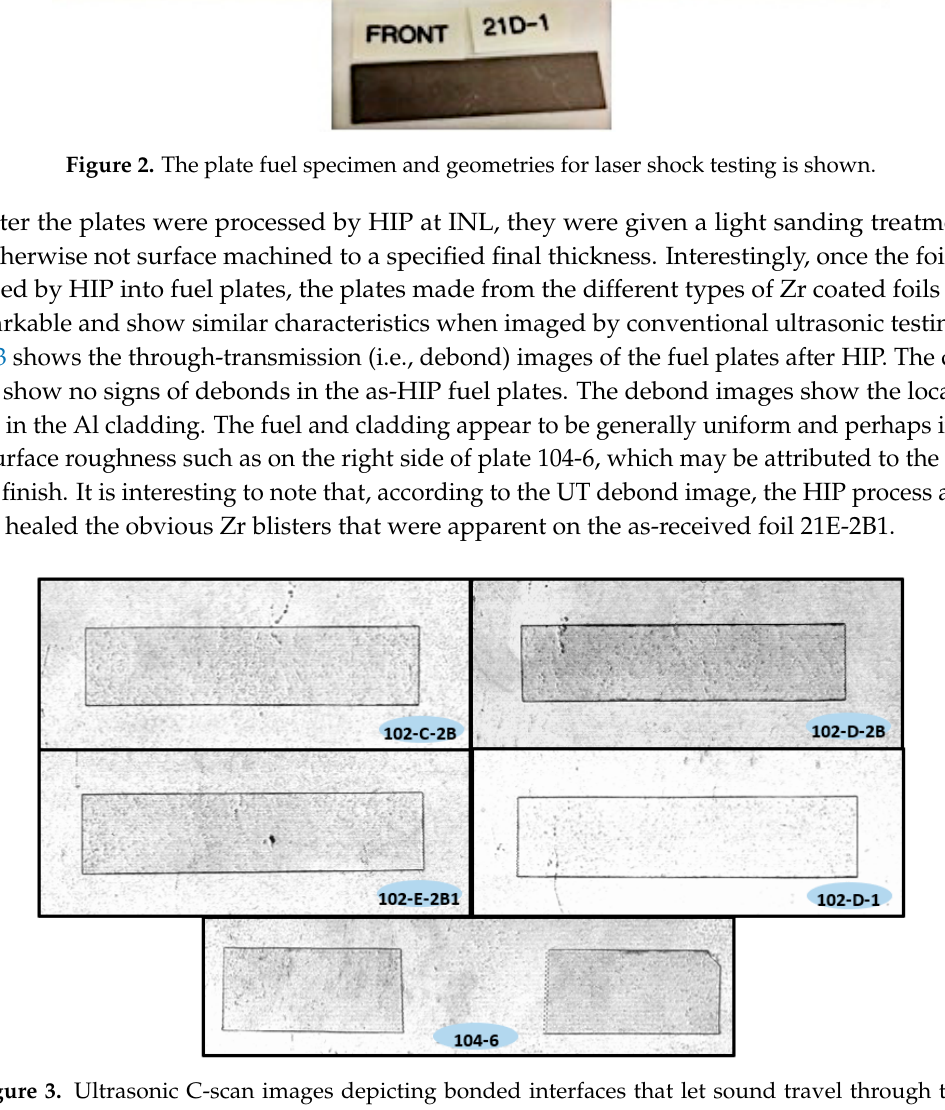
Figure 3. Ultrasonic C-scan images depicting bonded interfaces that let sound travel through the fuel plate. The hot isostatic pressing (HIP) process appears to have healed the coating blisters on foil